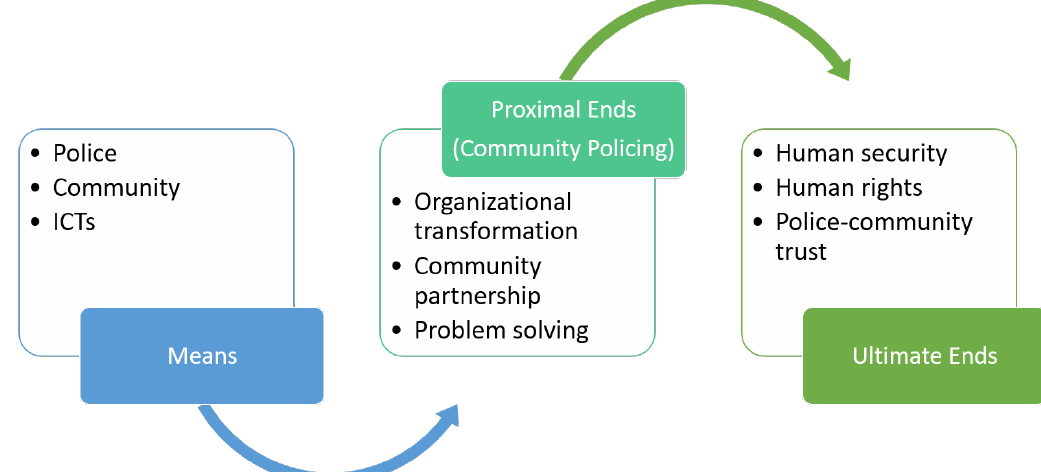
Figure 1. Relationship between ends and means of COP and